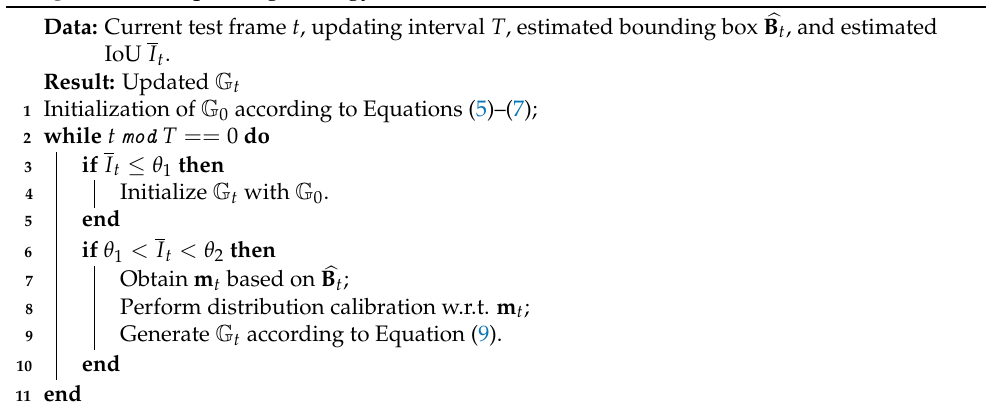
Algorithm 1: Updating strategy for reference